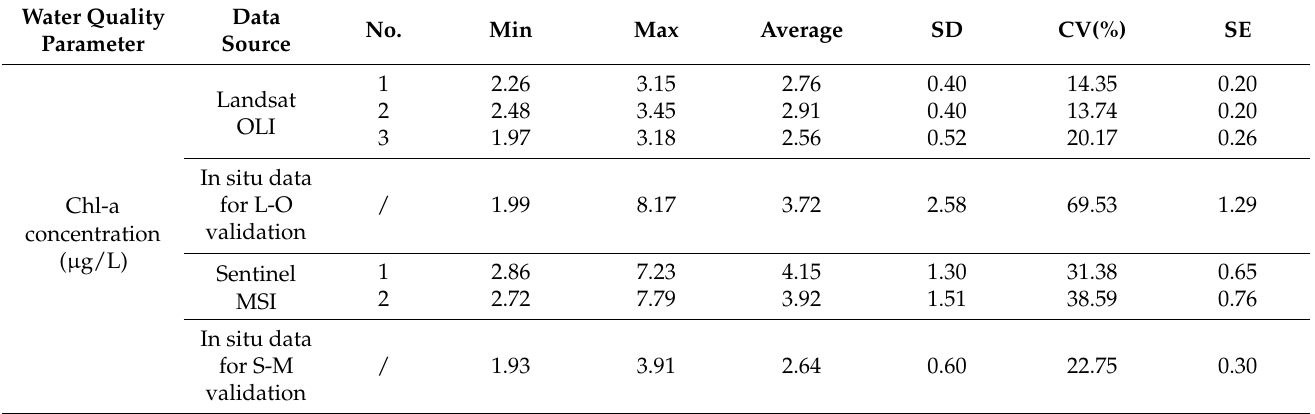
Table 12. Descriptive statistics of the in situ and predicted WQPs